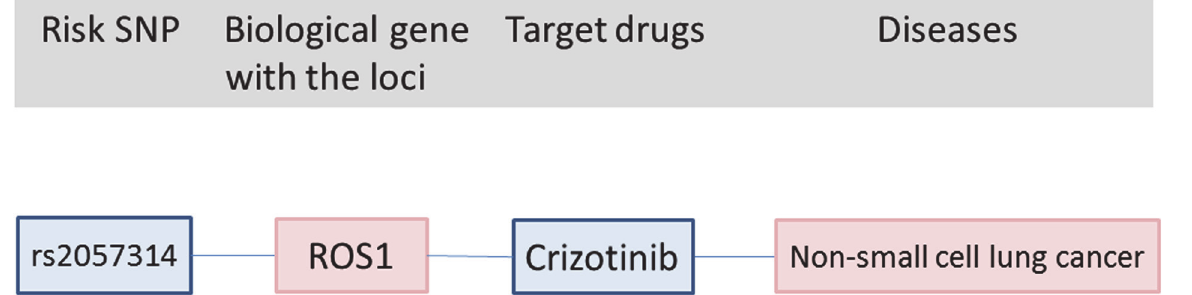
Fig 3. Connections between risk SNP, biological CRC genes and drugs indicated for other diseases.